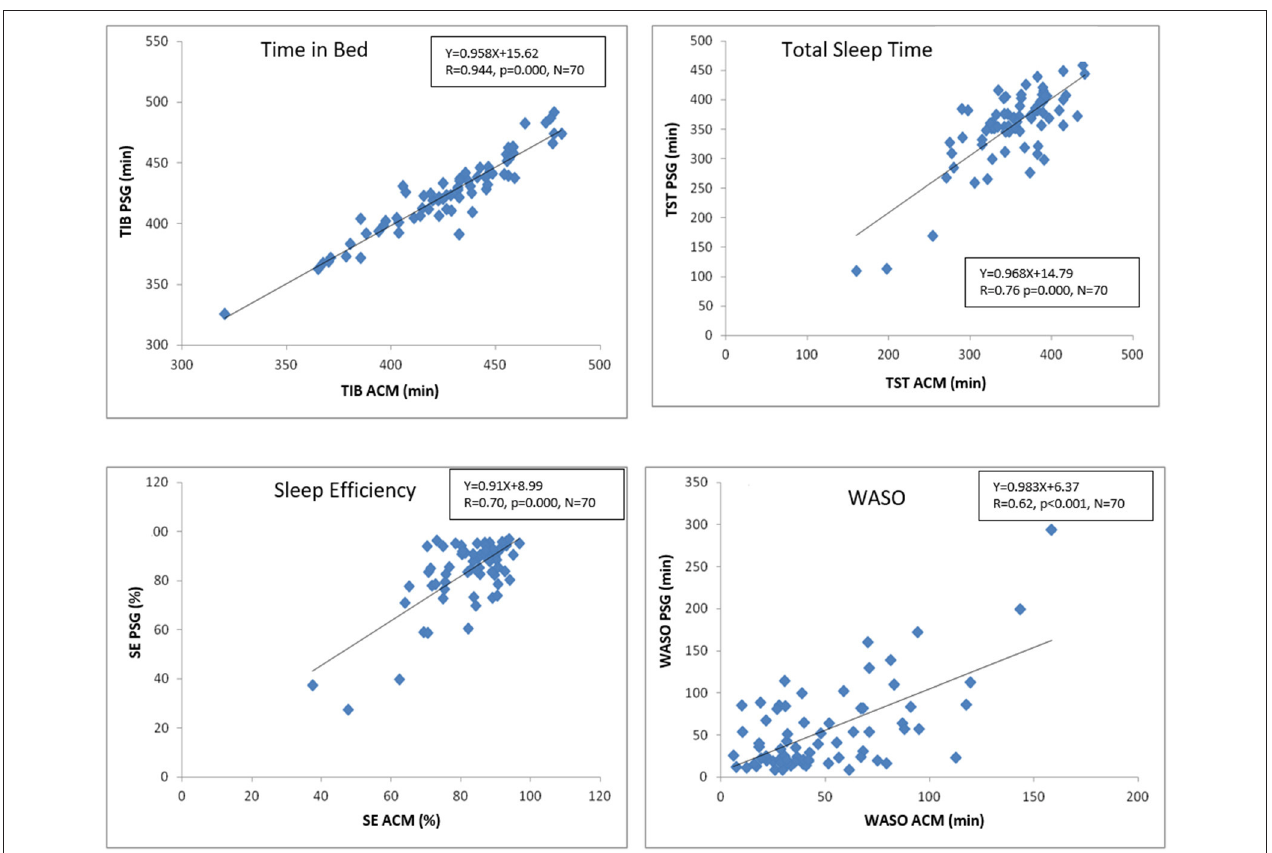
FIGURE 4 | Pearson correlations showing the correspondence between the main sleep parameters estimated by ACM and PSG. TIB, time in bed; TST, total sleep time; SE, sleep efficiency; WASO, wake time after sleep onset. The graph indicates the corresponding equation, its R value and its